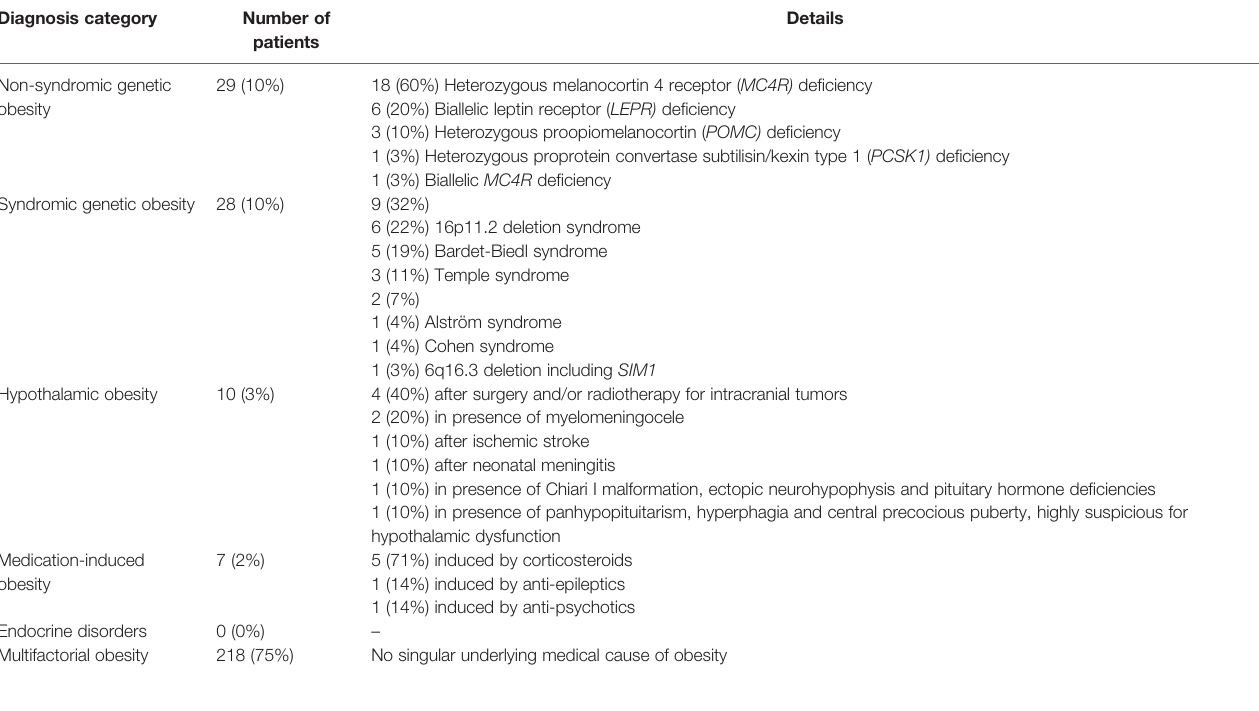
TABLE 1 | Diagnosed underlying medical causes of obesity in the study